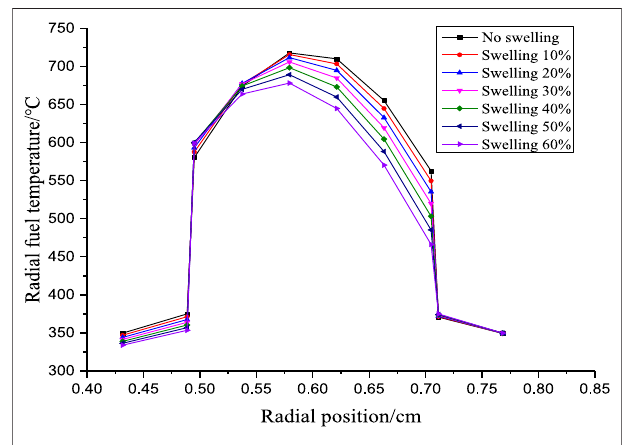
FIGURE 15 | Radial fuel temperature distribution with fuel pellet displacement